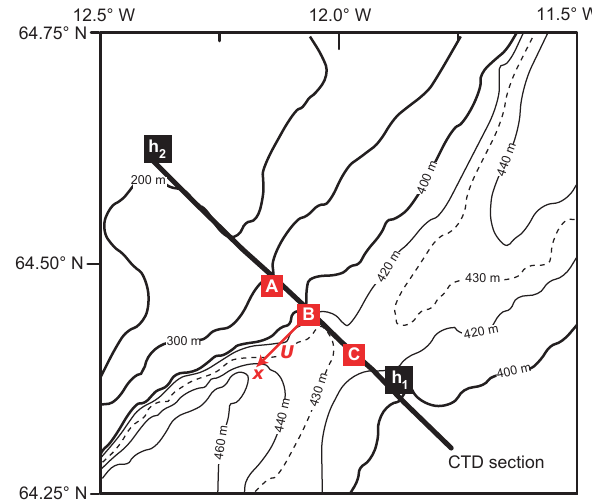
Figure 4. The region around the Western Valley with bottom topog- raphy based on ETOPO1. The positions of the three moorings of the field experiment are marked by red squares. Black squares indicate the two selected altimetry grid points. The thick black line shows a CTD section that was occupied by R/V Poseidon during the deploy- ment cruise in August 2016 and by R/V Magnus Heinason during the recovery cruise in May 2017. The red arrow indicates the chosen x direction for along-valley flow towards the Atlantic (225 ◦ ) with velocity component labelled U .